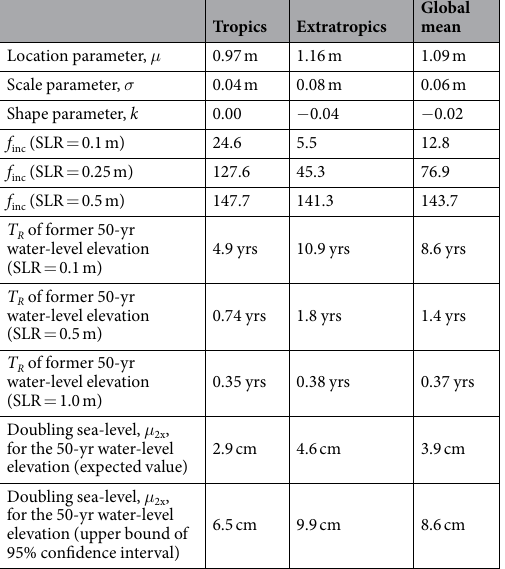
Table 1. Mean values of GEV parameters (Fig. 3), factors of increase (Fig. 4), and doubling SLR (Fig. 5) in the tropics, extratropics, and